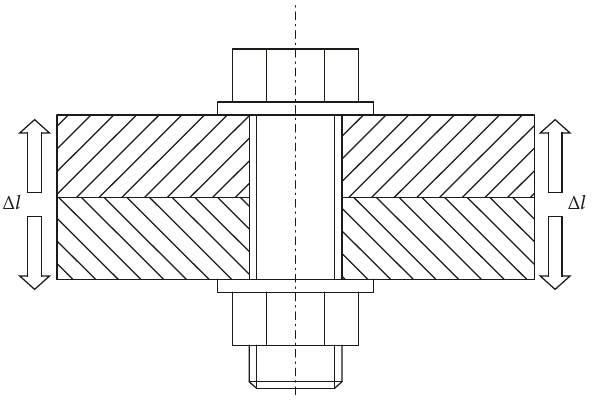
Figure 12: The loading diagram of the simplified way.